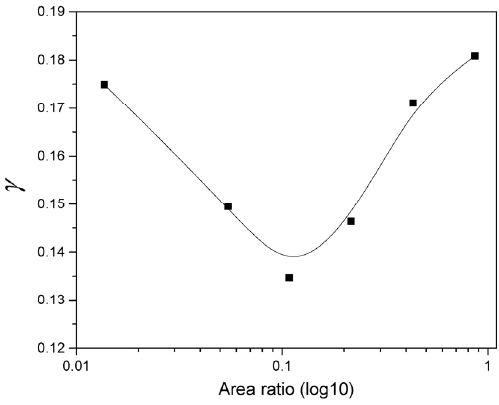
Fig. 12 The variation of γ with increasing area ratio.